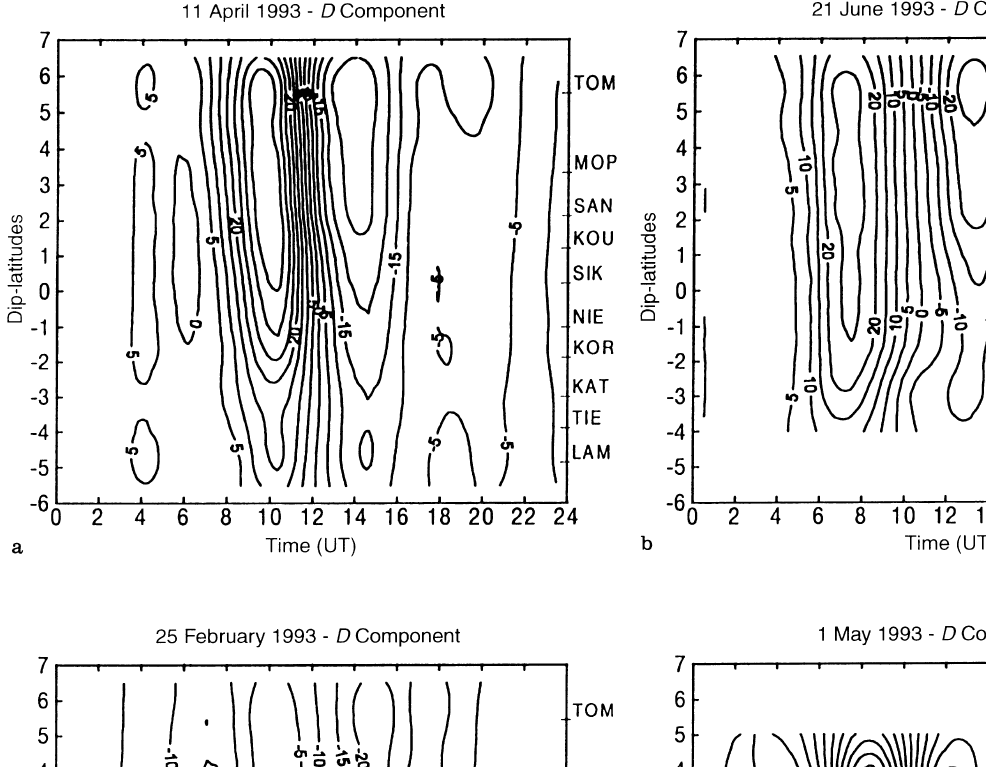
Fig. 7a–d. Contour maps of the daily variation of the east component D of the magnetic field: a and b example of days when a north e(cid:128)ect is stronger all day long (11 April 1993 and 21 June 1993). c Example of a day when a south e(cid:128)ect is stronger in the morning and a north e(cid:128)ect Fig. 8 during daytime, southward in February and northward in May.